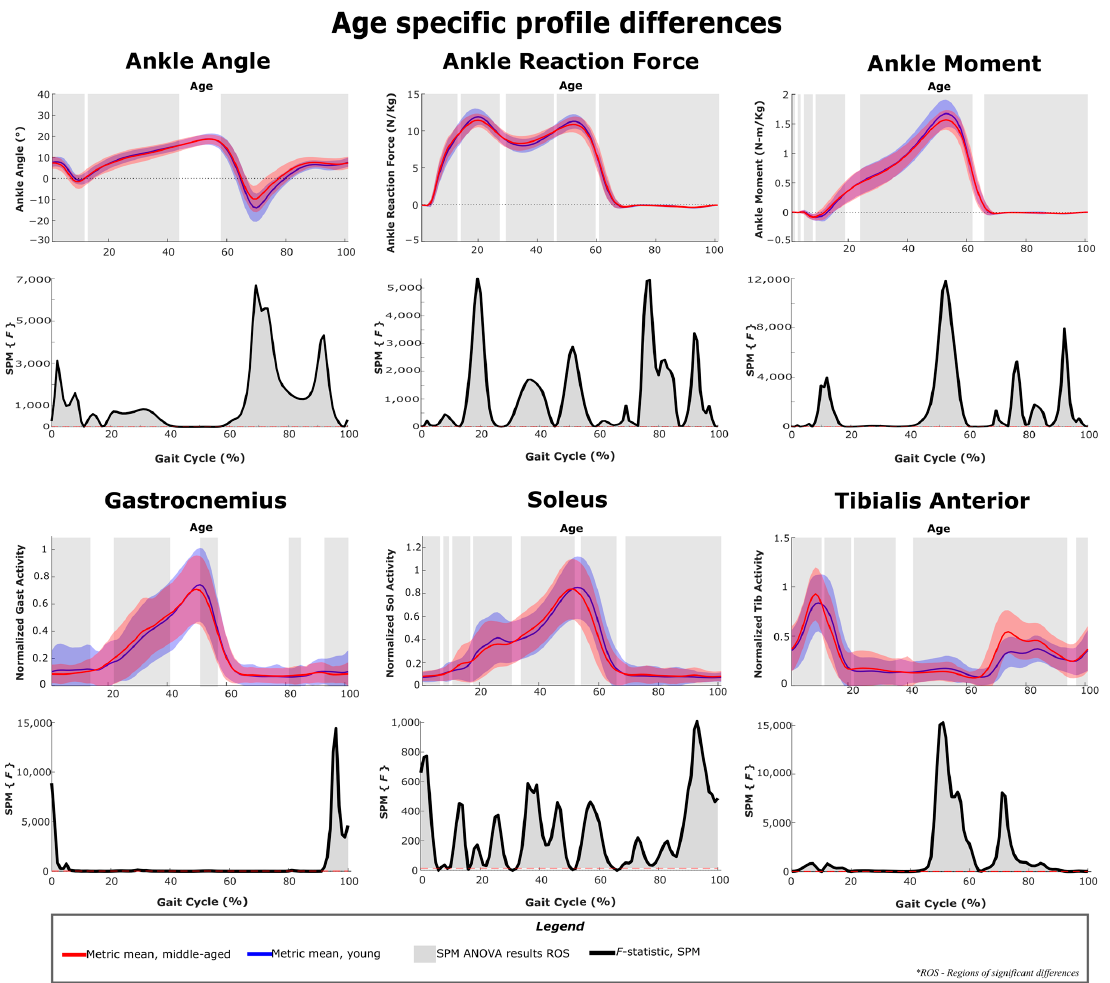
Figure 11. SPM ANOVA results and age-specific differences between the younger and middle-aged cohorts. Joint parameters are primarily related to the ankle joint. The F -statistic is qualitatively identical to the effect size and can be used as an indicator of practical significance.